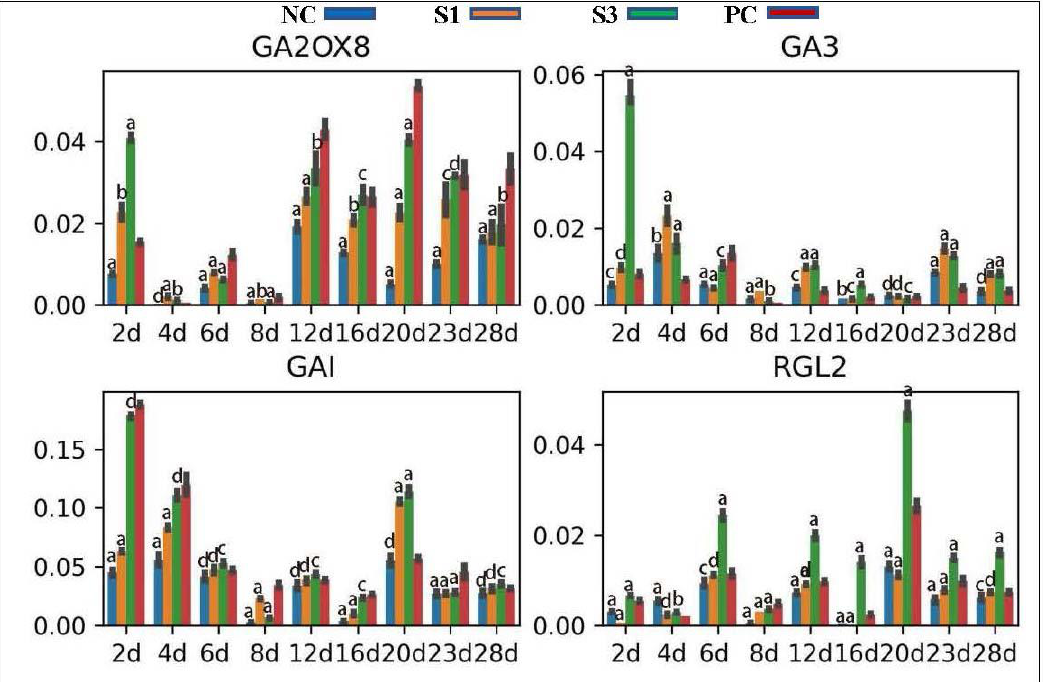
Figure 6. Expression patterns of genes participating in GA production and signaling transduction in differently treated samples. a, p -value < 0.001; b, p -value < 0.01; c, p -value < 0.05; d, p -value >